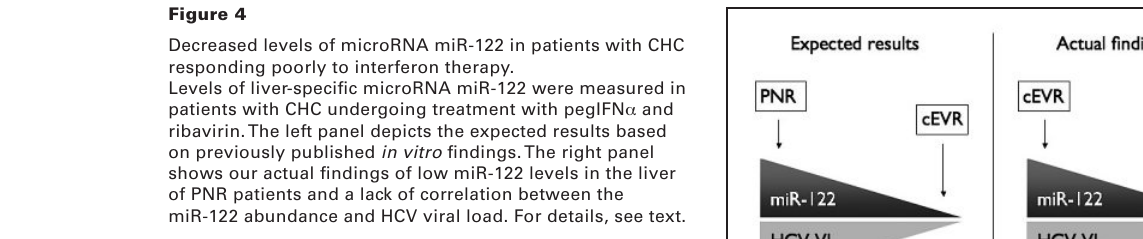
Decreased levels of microRNA miR-122 in patients with CHC responding poorly to interferon therapy. Levels of liver-specific microRNA miR-122 were measured in patients with CHC undergoing treatment with pegIFN α and ribavirin.The left panel depicts the expected results based on previously published in vitro findings.The right panel shows our actual findings of low miR-122 levels in the liver of PNR patients and a lack of correlation between the miR-122 abundance and HCV viral load. For details, see